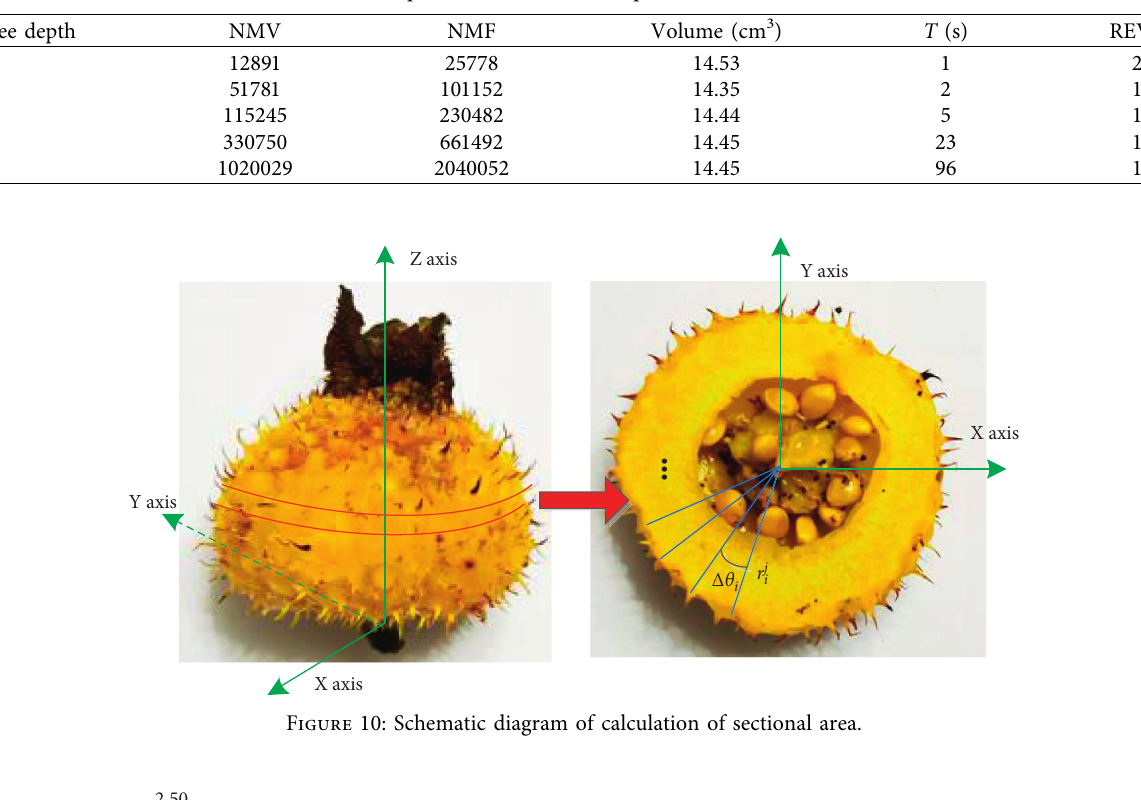
Table 3: Relationship between the Octree depth value and the volume error.